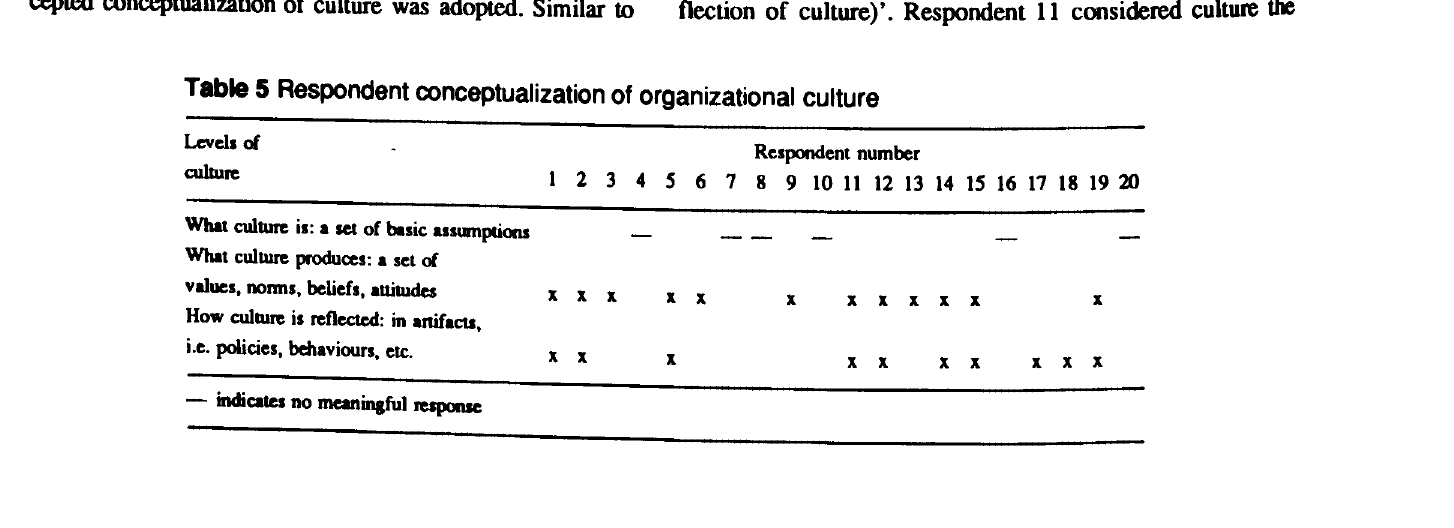
Table 5 Respondent conceptualization of organizational